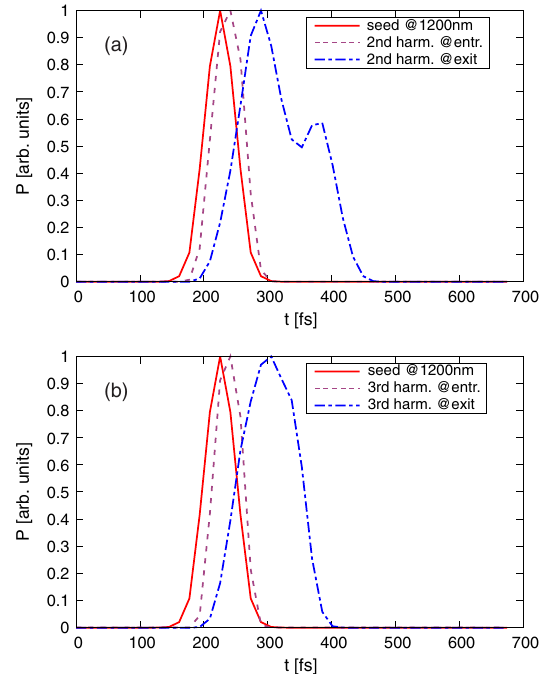
FIG. 4. Simulation of pulse lengths: (a) comparison of pulse lengths of the seed laser, 2nd harmonic radiation at the entrance and exit of the radiator; (b) comparison of pulse lengths of the seed laser, 3rd harmonic radiation at the entrance and exit of the radiator.